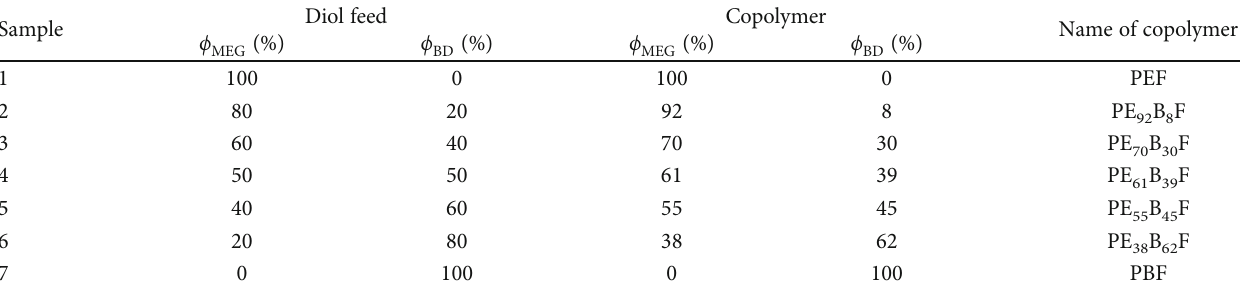
Figure 4: 1 H NMR spectra of prepared PEF, PBF, and PEF-co-PBFs (internal standard D Table 2: MEG and BD content of synthesized copolymers.